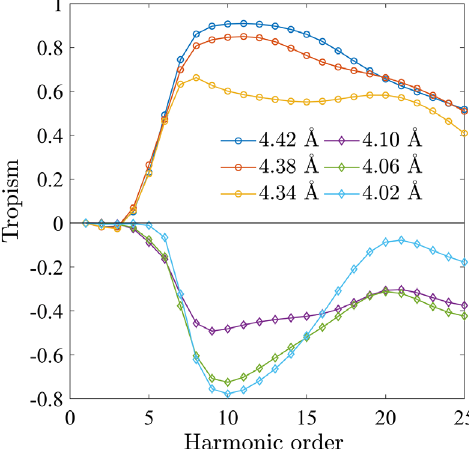
FIG. 7. HHG tropisms to the laser field in BiTeI with different lattice constants. The two lowest conduction bands and the two highest valence bands with Rashba splitting are considered for the calculations. Both the laser and nonlinear effects that we focus on are oriented along the k direction. The diagrams of the NP x and TP are drawn by lines with circles and diamonds, respec- tively. The two phases can be directly distinguished by signs of the tropisms. We do not plot the case approaching the phase transition because the band-inversion region and the band gap are too small to present significant